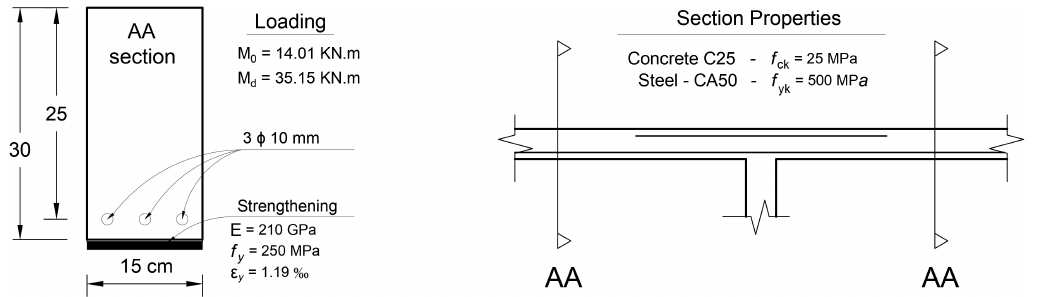
Table 1. Calculated carbon fiber strengthened area.